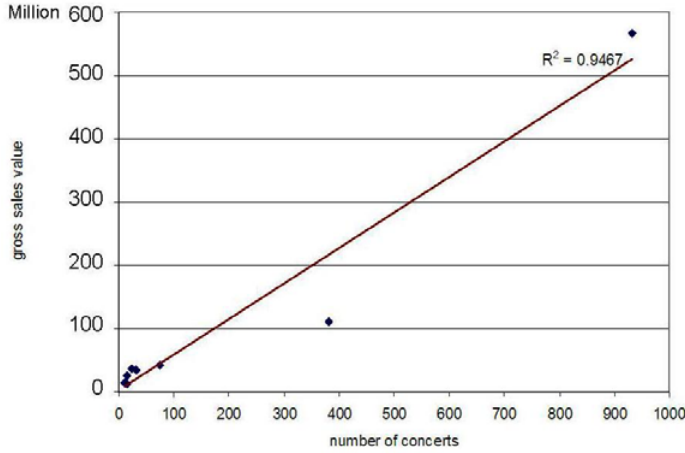
Figure 3: Pearson correlation between gross sales value and the number of concerts in